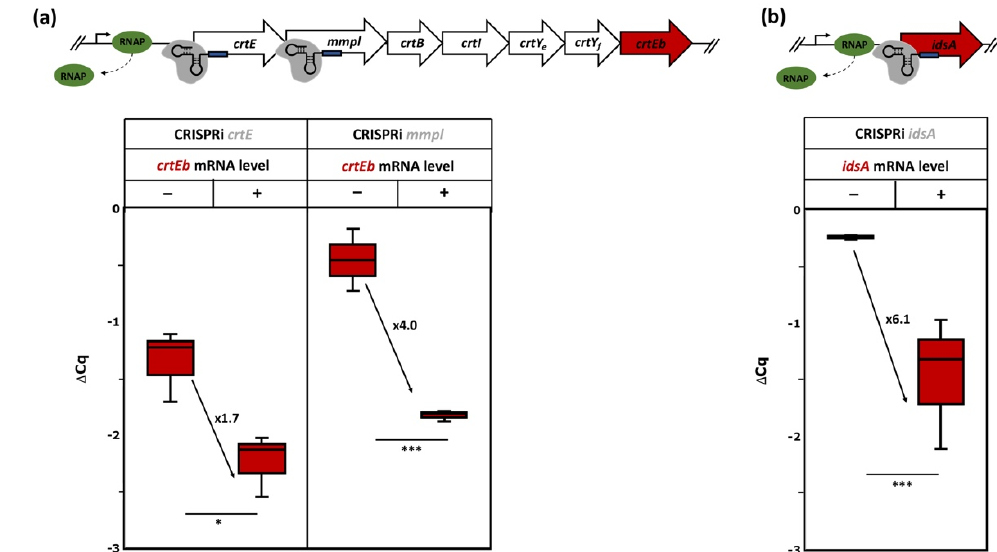
Figure 6. Schematic representation of the crt operon and idsA and qRT-PCR analysis of crtEb RNA levels upon CRISPRi targeting of crtE or mmpL ( a ) or of idsA RNA levels upon CRISPRi targeting of idsA ( b ). Cells exponentially growing in 40 g L − 1 of glucose CGXII minimal medium with (+) or without ( − ) induction using 1 mM IPTG and 0.25 µg mL − 1 of aTc were analyzed. Mean values and standard deviations of three biological replicates are given. The p -values of <0.001 (***), and <0.05 (*) were calculated using Student’s t -test (two sided, unpaired). For abbreviations, see Figure 3.